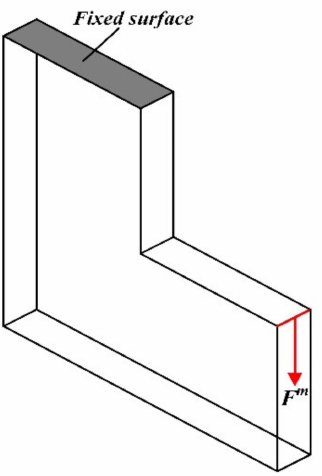
Figure 17. 3D L-beam design domain.